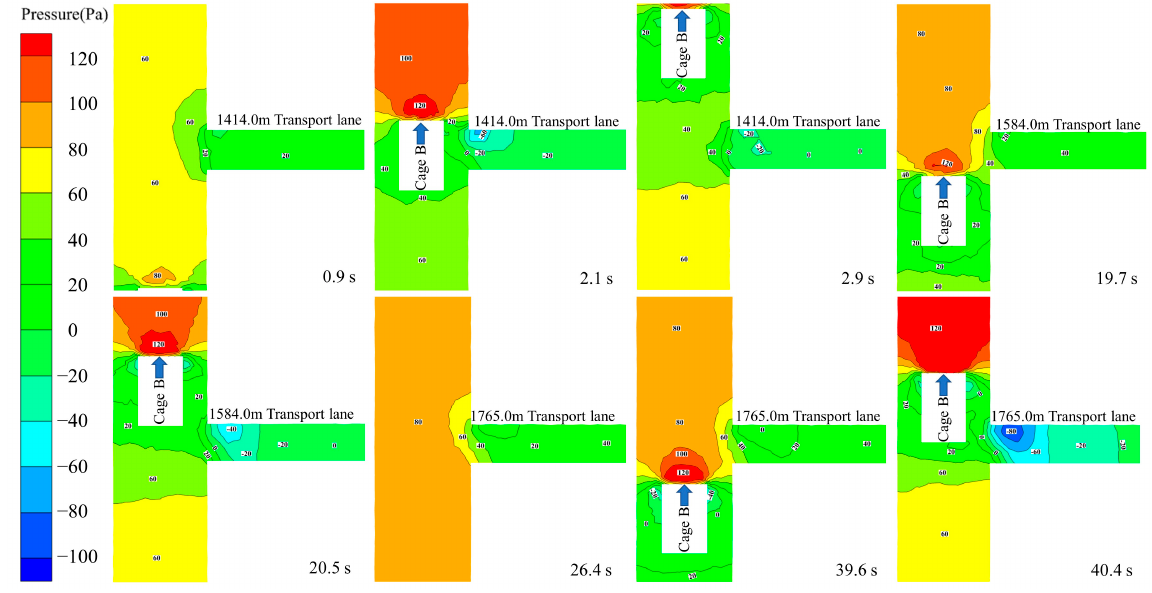
Figure 10. Pressure field distribution of each transport lane in x = − 1 m section.